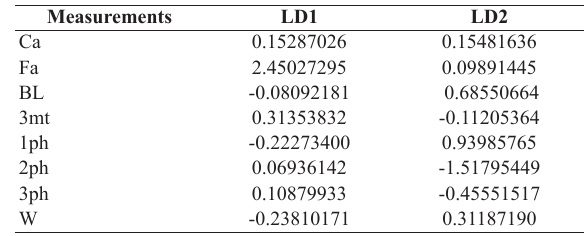
Table 2. Coefficients of the linear discriminants. Abbreviations of the measurements are described in the section of Materials and methods.